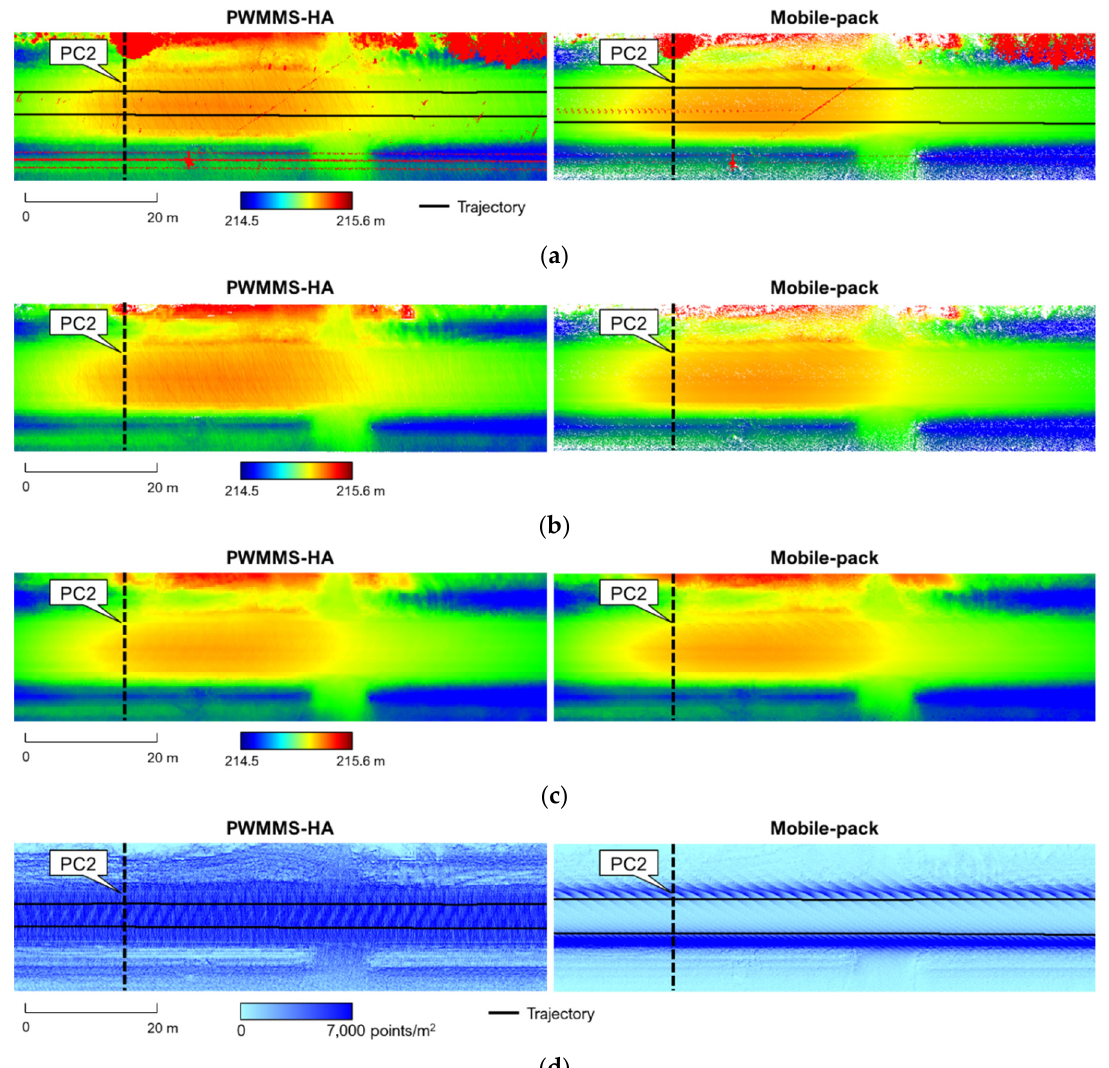
Figure 17. LiDAR-based products from PWMMS-HA and Mobile-pack (showing an 80-m long area near location PC2 ): ( a ) point cloud and trajectory, ( b ) bare earth point cloud, ( c ) digital terrain model (DTM), and ( d ) point density of the bare earth point cloud and trajectory.